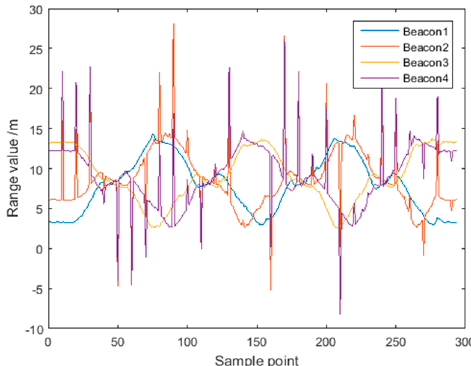
Figure 16. UWB range values for Route 2 where 10% of data from Beacons 2 and 4 are contaminated with noise.